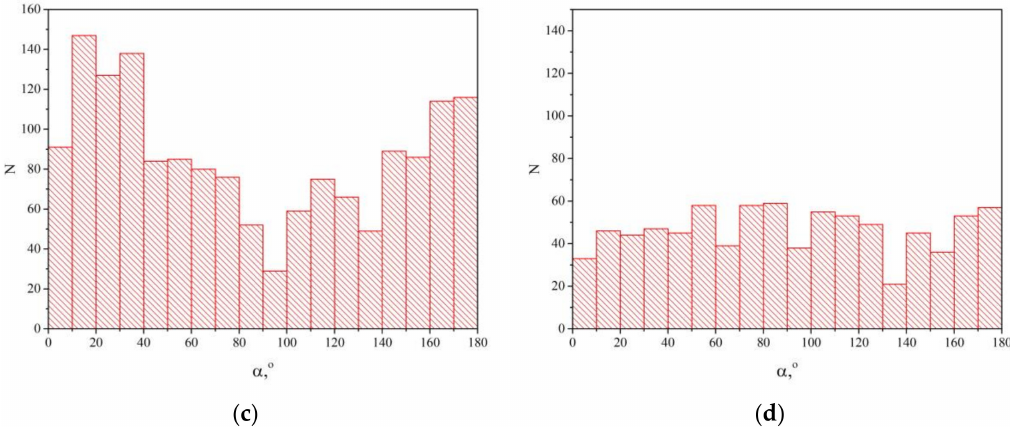
Figure 7. The scheme of measuring the orientation in the horizontal plane of the elementary dimple of tearing ( a ), and the distributions of this parameter for static deformation ( b ), DNP1 ( c ), and (DNP2) ( d ).